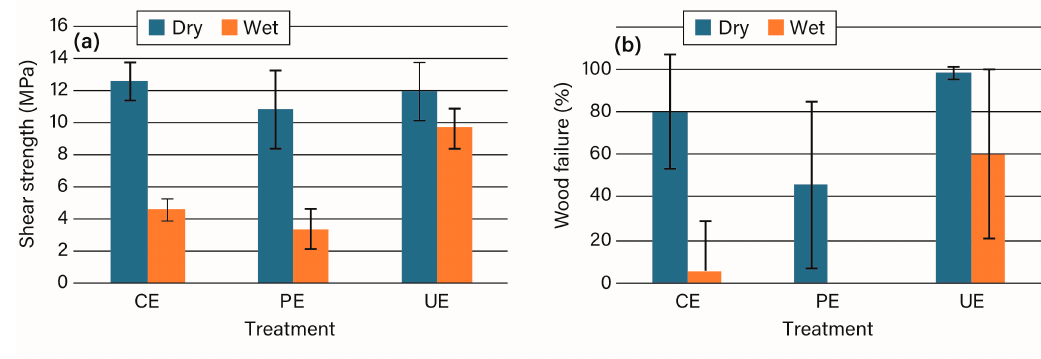
Figure 4. The ( a ) shear strength and ( b ) percentage wood failure for epoxy bonding of unmodified (CE), planed acetylated (PE), and unplaned acetylated (UE) wood.